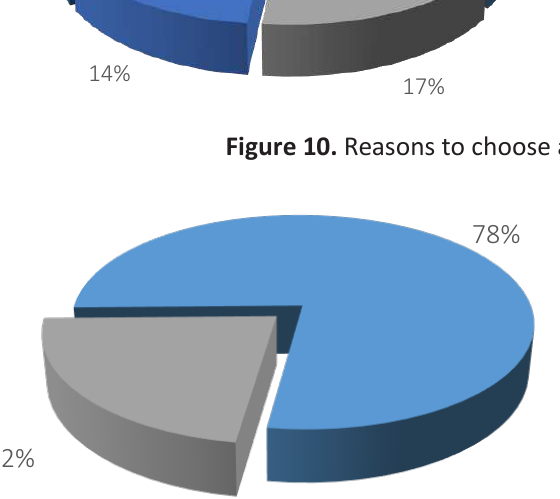
Figure 11. Desire to travel again in Covid-19 times